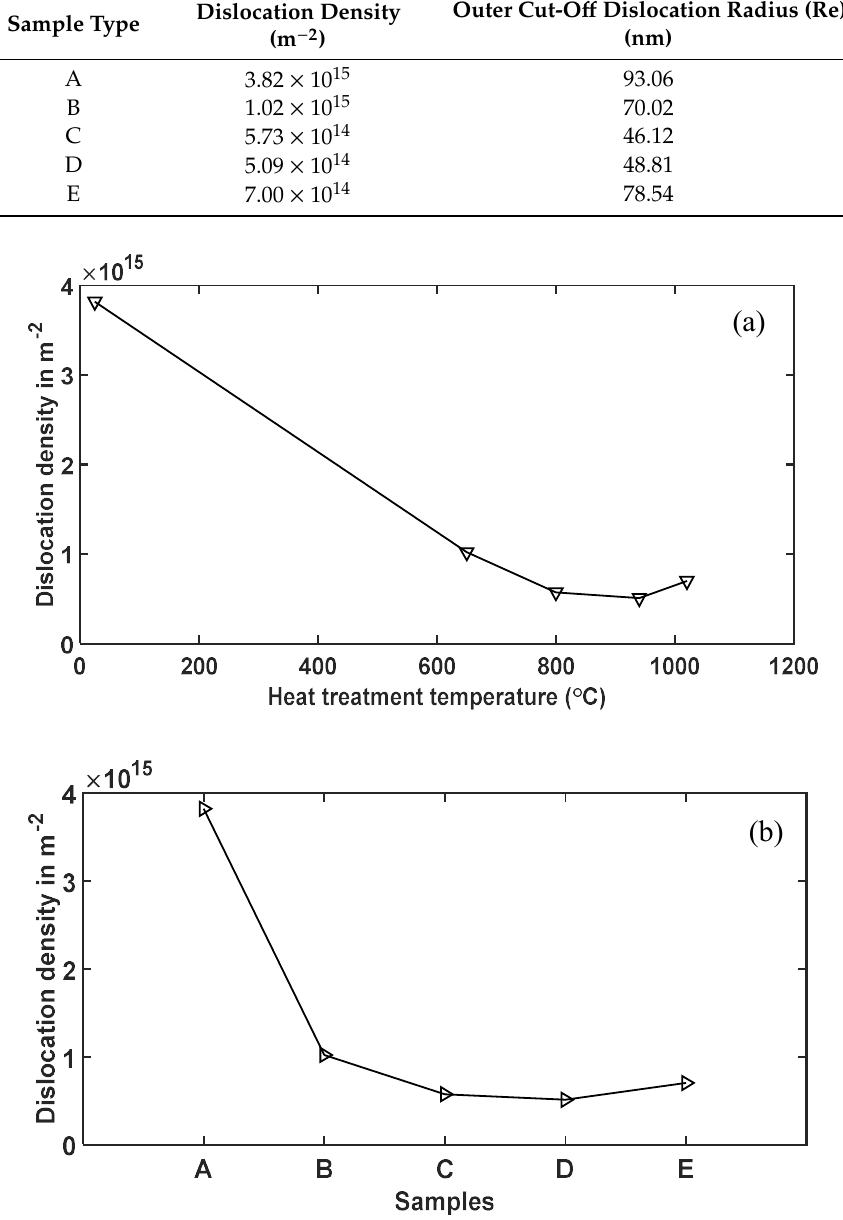
Figure 13. Trend of dislocation density ( a ) with heat treatement temperature and ( b ) in nonheat-treated (samples A) and heat-treated (samples B, C, D and E) microstructures of DMLS Ti6Al4V(ELI). Table 5. The density and effective outer cut-off dislocation radius resulting from the MWA method.